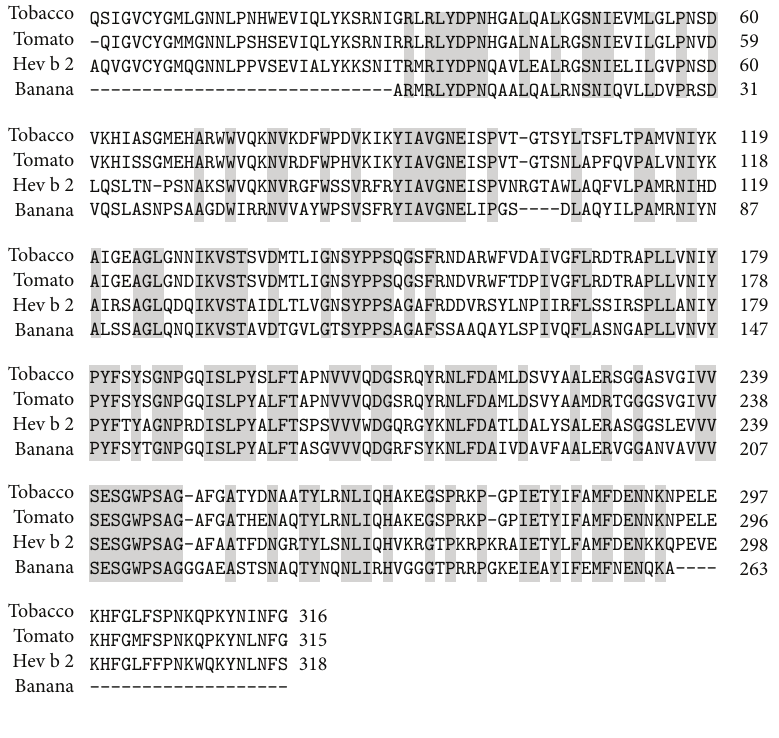
Figure 1: Multiple sequence alignment of 𝛽 -1,3-glucanases from tobacco, tomato, banana, and latex (Hev b 2). The identical residues are highlighted in